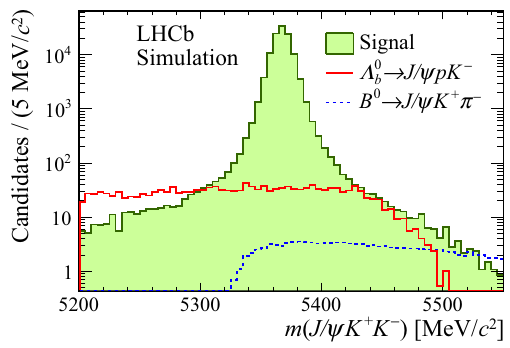
Fig. 1 Distribution of the invariant mass of B 0 s candidates, selected fromsimulated B 0 s → J /ψ K + K − (greenfilledarea), Λ 0 (solid red line) and B 0 → J /ψ K + π − (dotted blue line) decays. The distributions are weighted to correct differences in the kinematics and the resonance content between simulation and